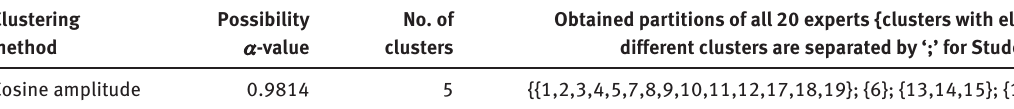
Table 8: The Partitioning of Teachers on Different Intervals of α -Cut 0.98 for Student ID 12. Clustering